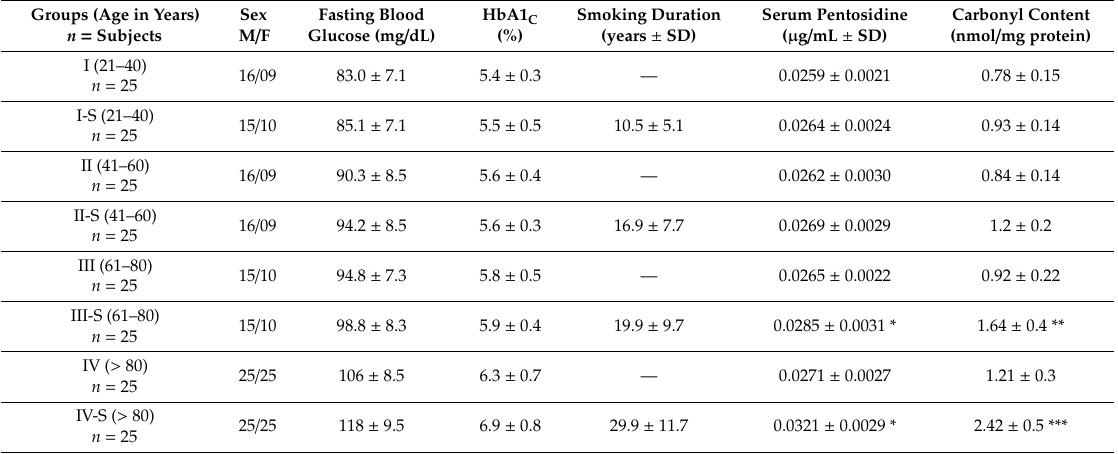
Table 2. Demographic and clinical characterizations of di ff erent individuals based on di ff erent age groups with or without smoking habits.